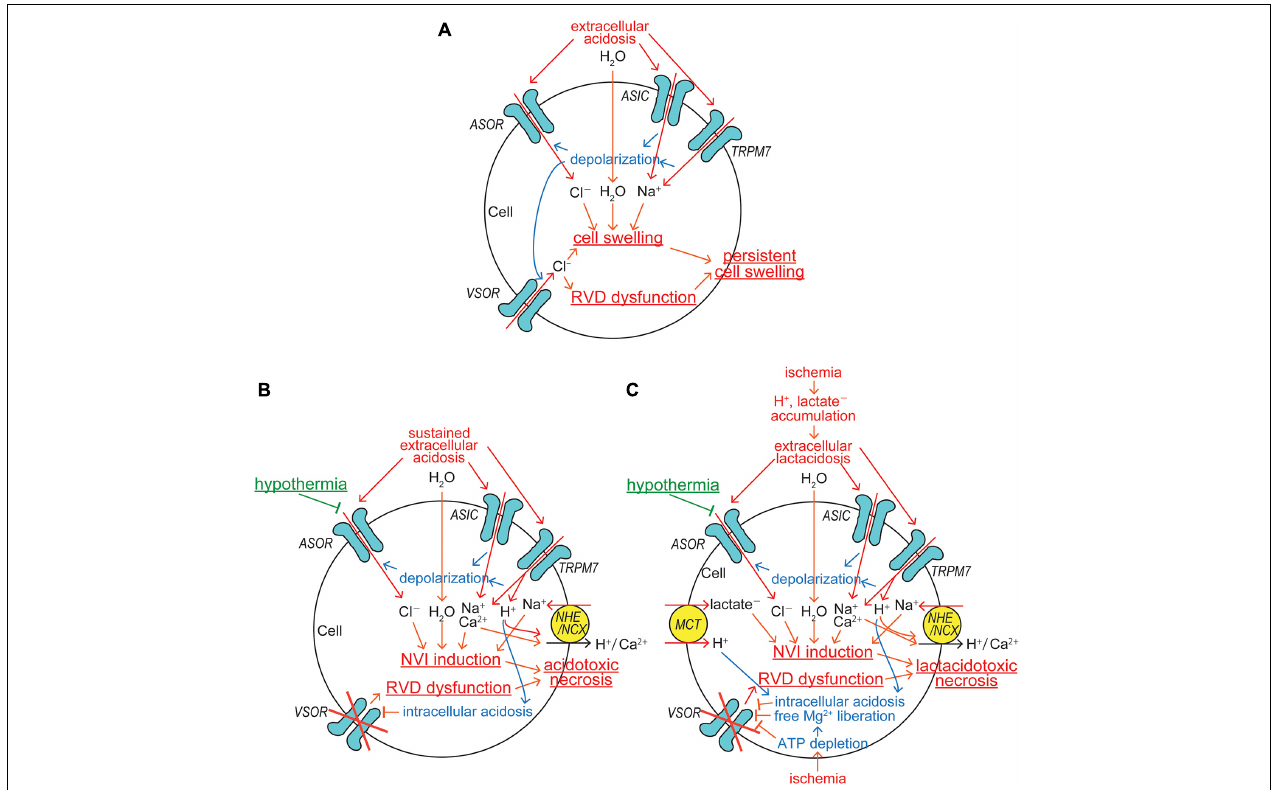
FIGURE 2 | ASOR/PAC involvements in induction/protection of cell swelling and death under acidosis and ischemic conditions. (A) The mechanisms for induction of persistent cell swelling under acidosis. (B) The mechanisms for induction of acidotoxic necrosis and its hypothermic protection under sustained acidosis. (C) The mechanisms for induction of lactacidotoxic necrosis and its hypothermic protection under ischemic conditions (See the text for